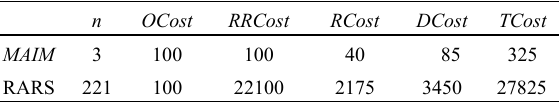
Table 3 gives the comparison results of experiments.